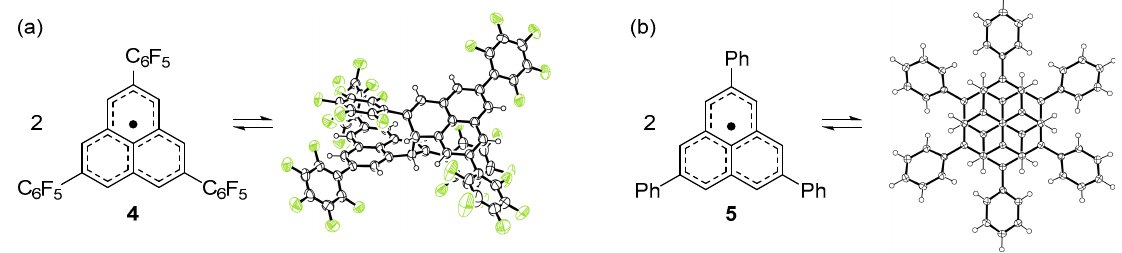
Figure 3. Dimerization mode of ( a ) 4 and ( b ) 5 .